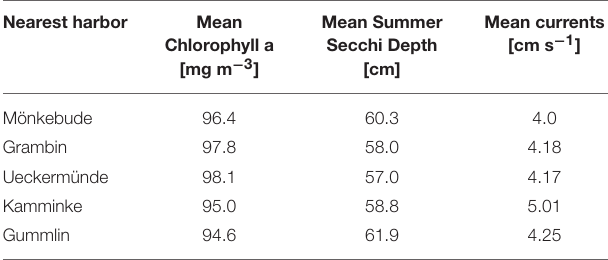
TABLE 3 | Background conditions for the mussel farm